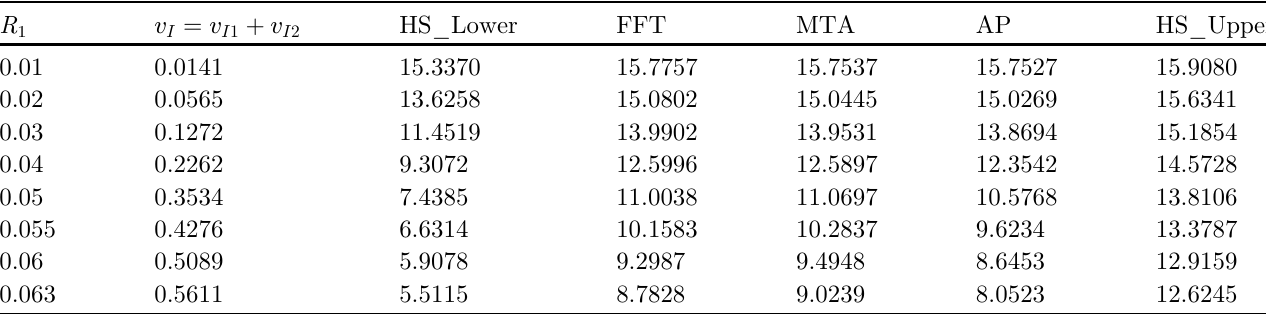
Table 6. Comparison of results ( m eff ) of FFT, MTA, DA, and HS bound for the case (C), R 1 ¼